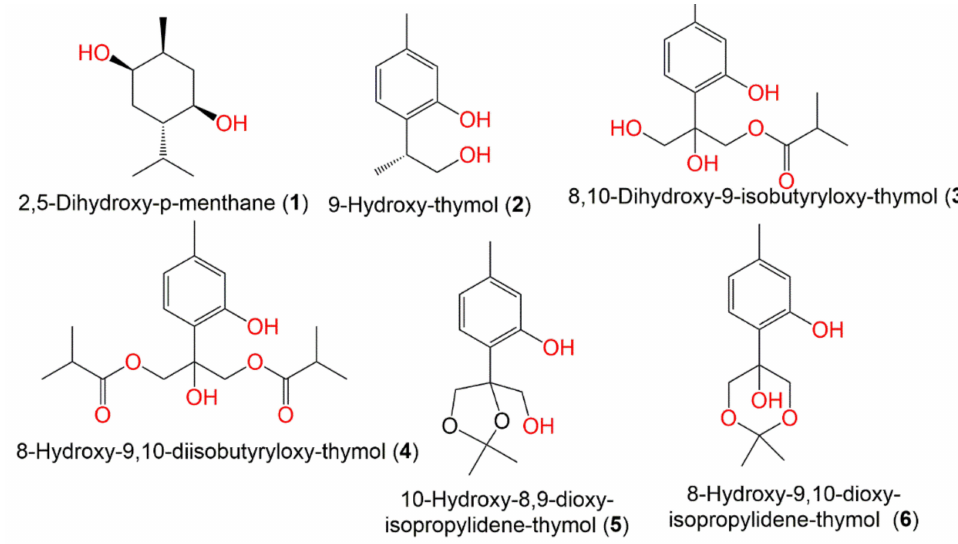
Figure 3. Structures of monoterpenes ( 1 – 6 ) reported from C. abrotanoides